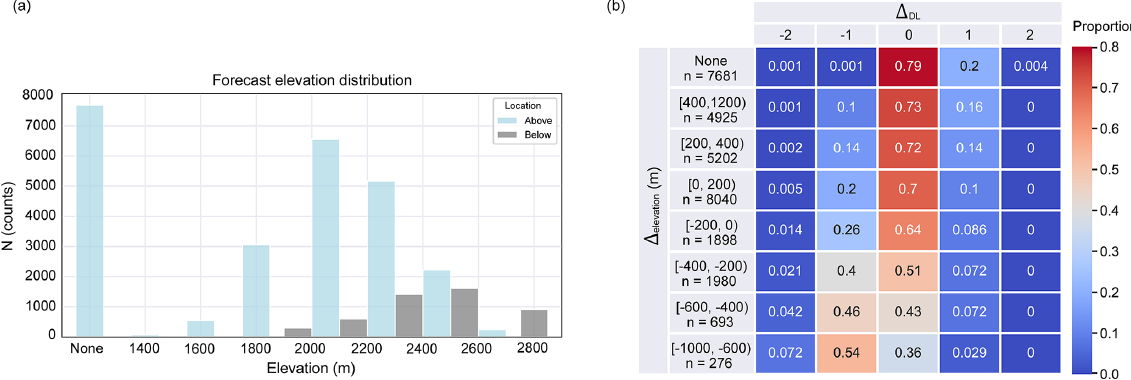
Figure 9. (a) Frequency of the elevation indicated in the public forecasts with the number of stations that are located above and below this elevation. The class of none contains the samples for the days when no information was indicated in the bulletin. (b) Heat map of the proportions of samples (row-wise normalized) for each of the eight elevation classes ( (cid:49) elevation = elevation ( station ) − elevation ( forecast ) ) versus the range of prediction bias ( (cid:49) DL ) of the model RF 1. The total number of samples in each elevation class is denoted with n